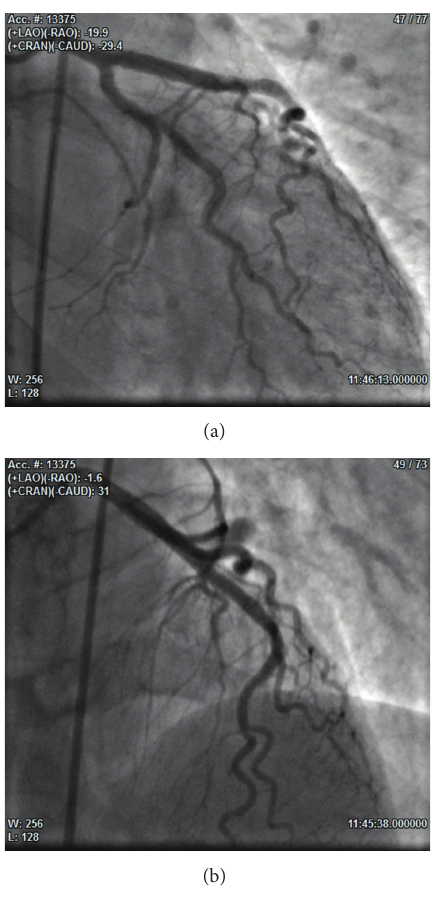
Figure 5: (a) (20 ∘ RAO and 29 ∘ CAU) and (b) (1 ∘ RAO and 31 ∘ CRA): final result after PCI with implantation of two DES in overlapping in the proximal-medium tract of